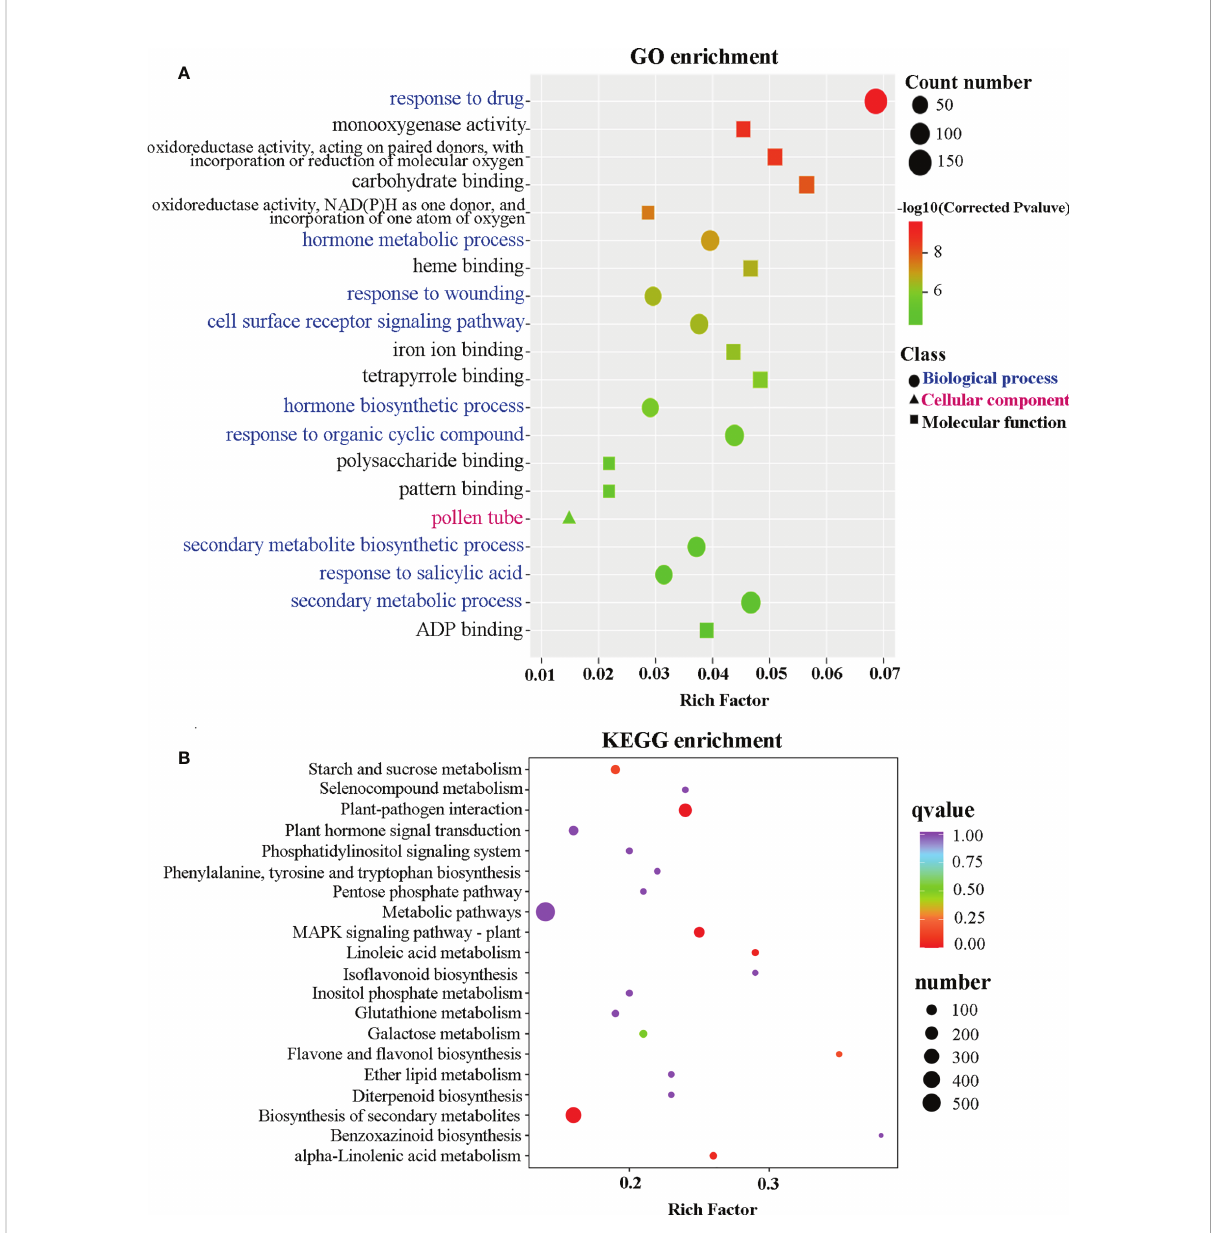
FIGURE 2 Scatter plot of the GO and KEGG enrichment analyses based on the DEGs. (A) Scatter plot of the GO enrichment analysis based on the DEGs. The ordinate represents a GO term. The abscissa indicates a rich factor. The greater the rich factor, the greater the degree of enrichment. The larger the point, the greater the number of DEGs enriched in the GO pathway. The redder the color of the dot, the more signi fi cant the enrichment. (B) Scatter plot of the DEGs enriched in the KEGG pathways. The ordinate indicates the KEGG pathway. The abscissa indicates a rich factor. The greater the rich factor, the greater the degree of enrichment. The larger the point, the greater the number of DEGs enriched in the KEGG pathway. The redder the color of the dot, the more signi fi cant the